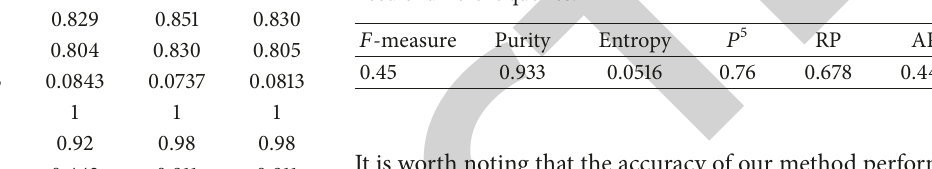
Table 11: The results of evaluation metrics under same information need of different